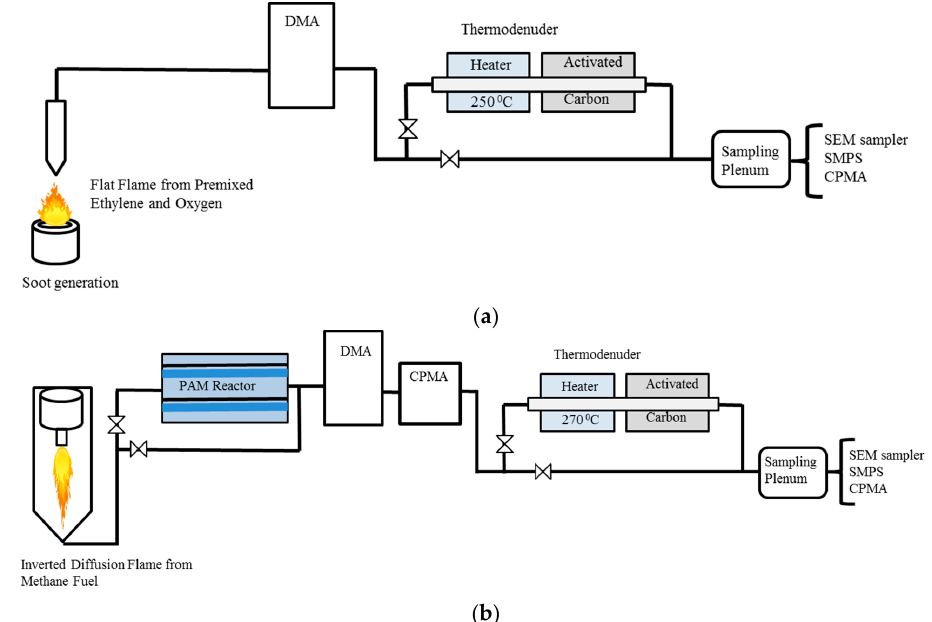
Figure 1. Soot generation and sampling set-ups in ( a ) Boston College Experiment 2 (BC2) and ( b ) Boston College Experiment 4 (BC4).